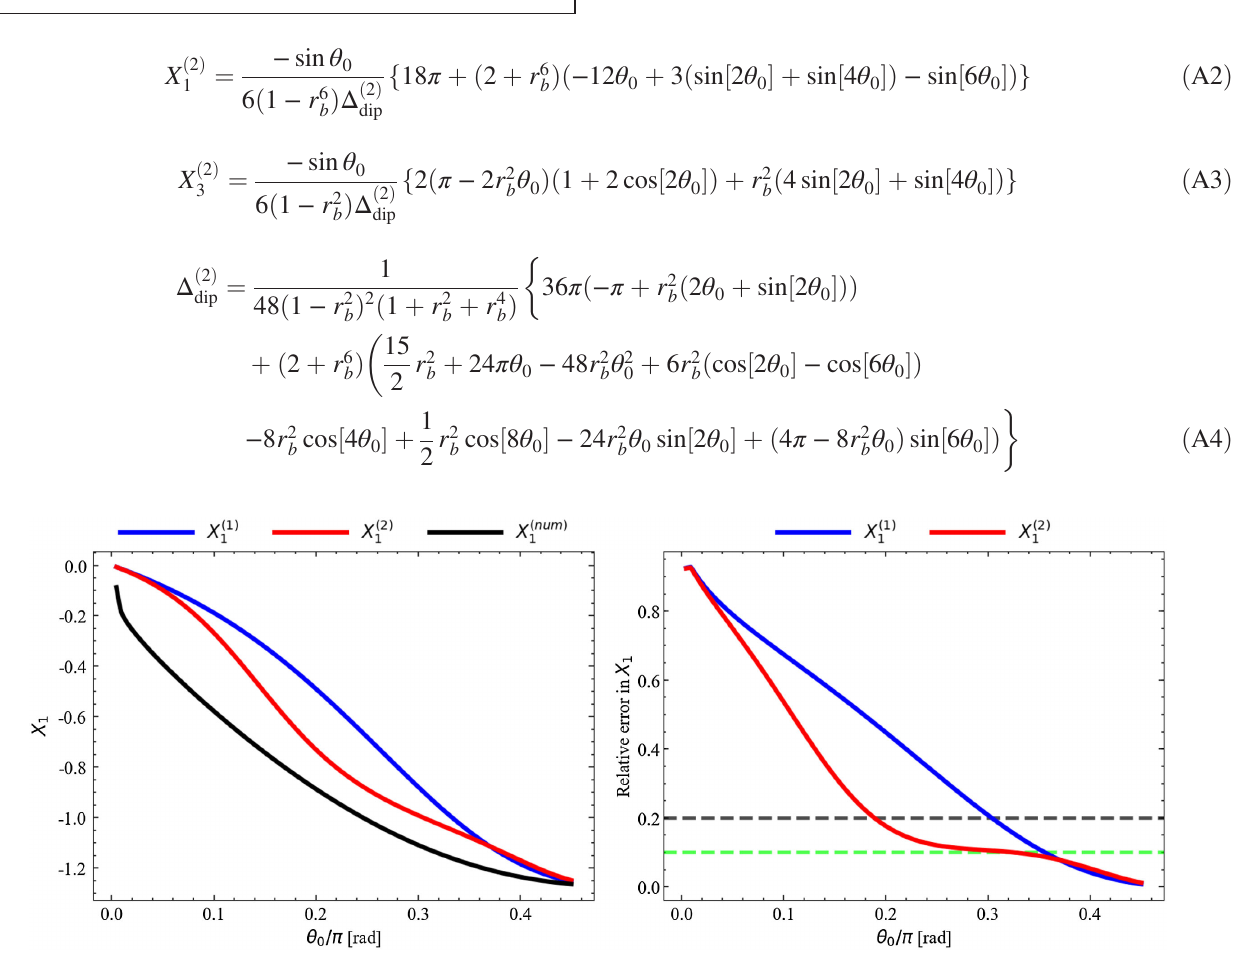
1 Þ ð 2 Þ 1 ; X 1 and the exact numerical value X 1 Þ ð 2 Þ 1 ; X 1 compared to the exact value as functions of